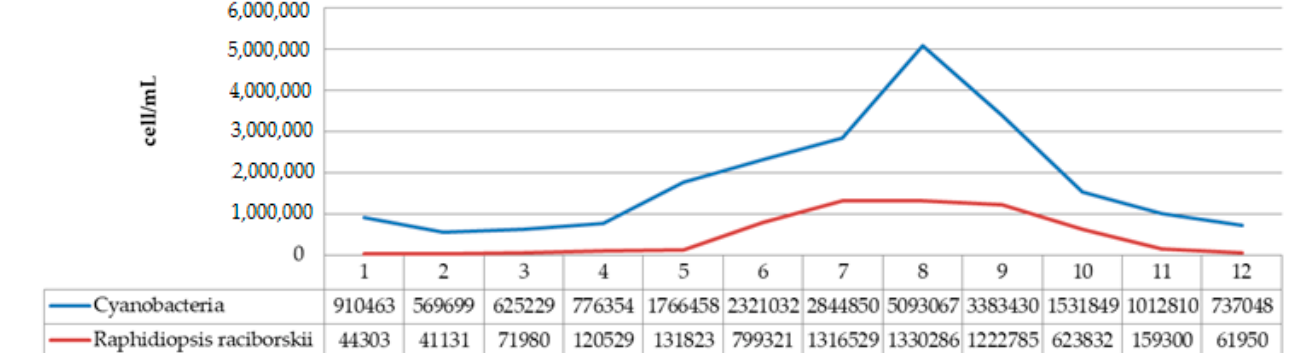
Figure 12. Dynamics of the average cell number of cyanobacteria compared to abundance of R. raciborskii